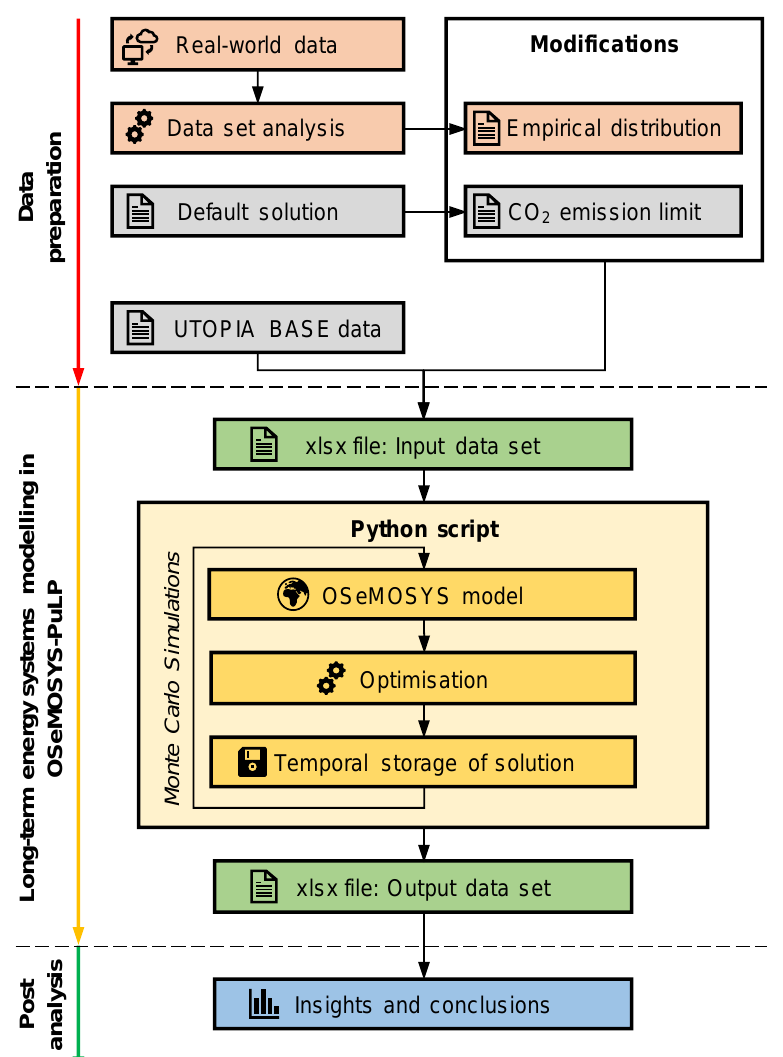
Figure 2. Methodological framework and analysis process.